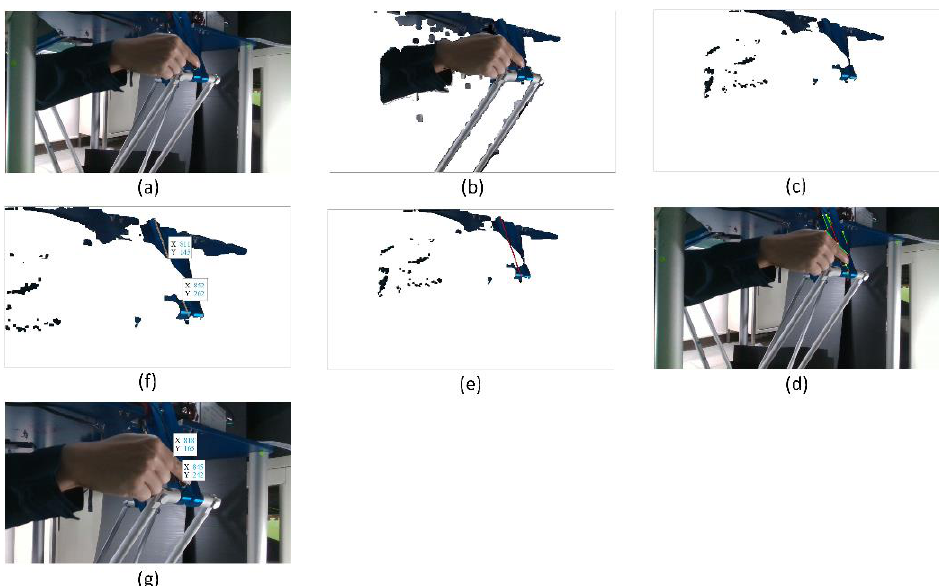
Figure 17. The collision isolation procedure in Case 2: ( a ) The image captured; ( b ) The limited workspace; ( c ) The blue region; ( d ) Straight lines along arms; ( e ) The direction of the arm; ( f ) The intersections of the blue region and the non-blue region in the arm direction; ( g ) The contact point. At 5.6 s, a collision occurred on the arm, and the external force reached the maximum value. The intersection coordinate is [ 232 885 ] T (pixels), and the depth at this point is 409 mm. The contact point coordinate is identified as [ − 121.99 278.95 − 99.66 ] T (mm).